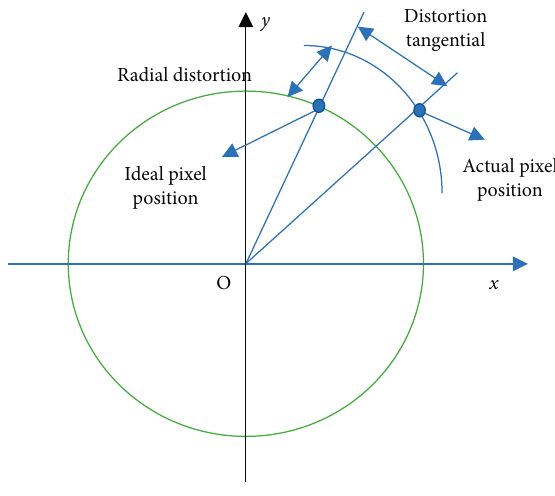
Figure 5: Camera distortion